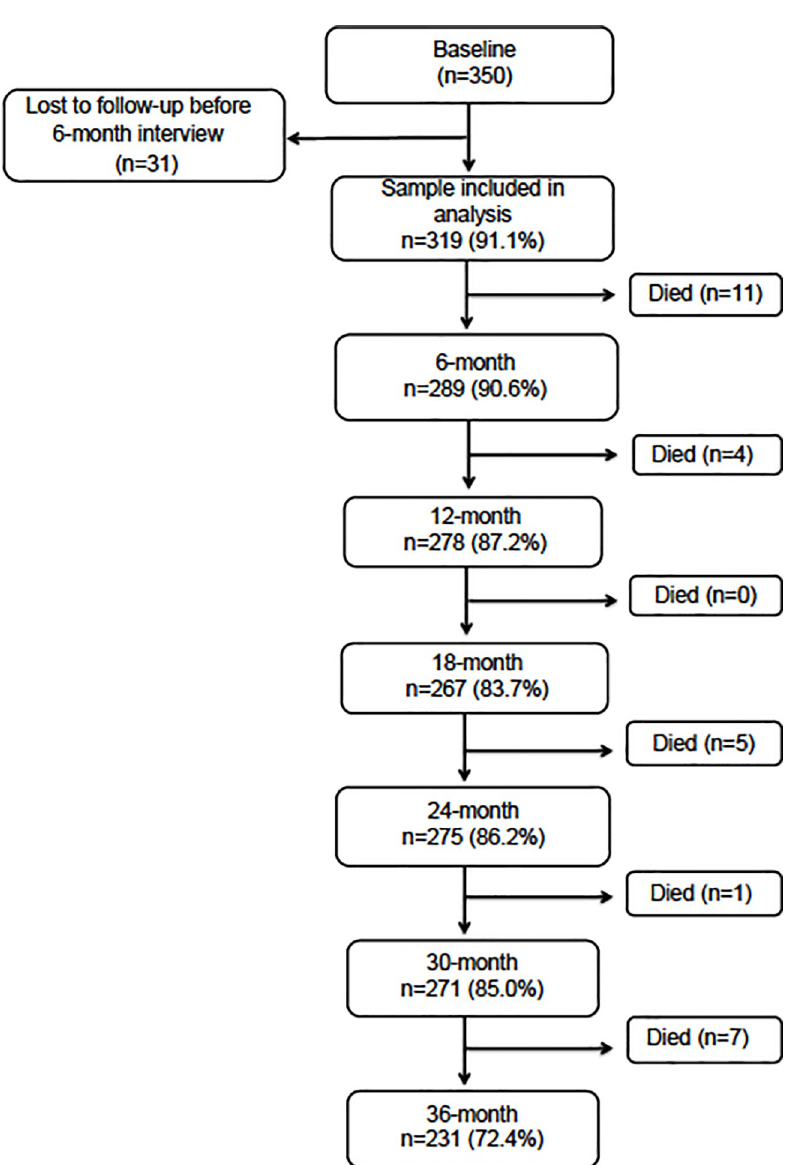
Fig 1. Flow-chart of follow-up of 350 homeless older adults. The figure shows the number of individuals enrolled at baseline and followed at 6-month intervals over 36-months’ follow-up. Deaths between each follow-up are noted.